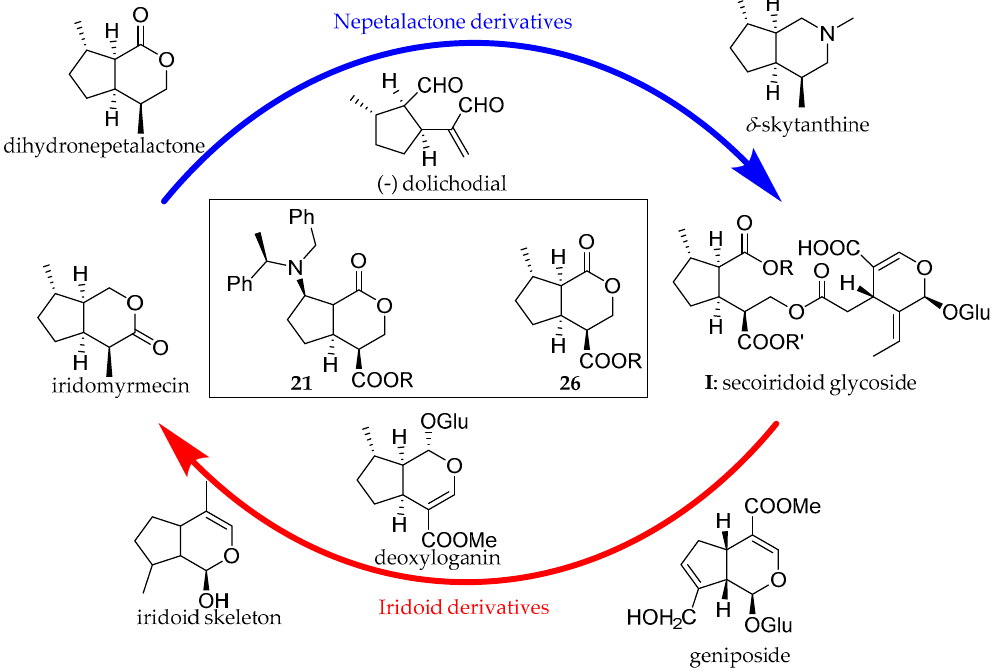
Figure 1. Some main nepetalactone and iridoid skeletons.